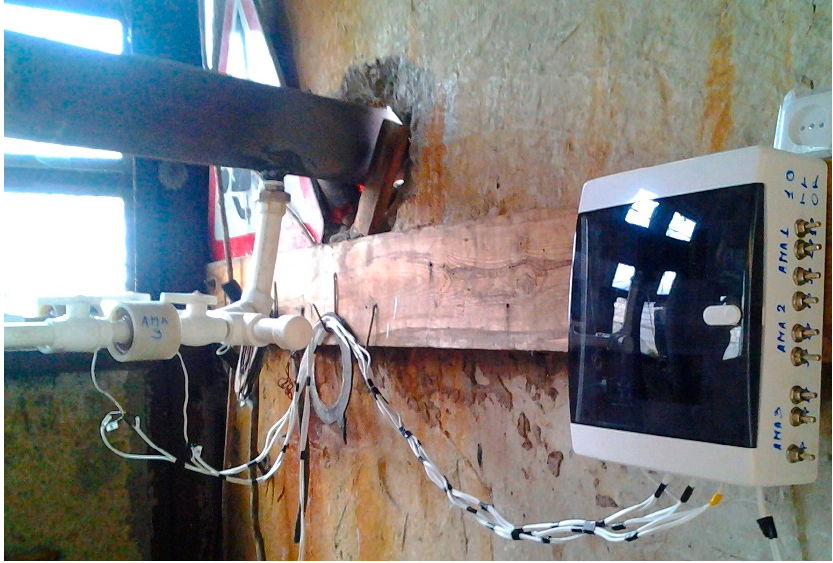
Figure 18. An acoustic–magnetic device with an automation system mounted on a geothermal supply pipe.